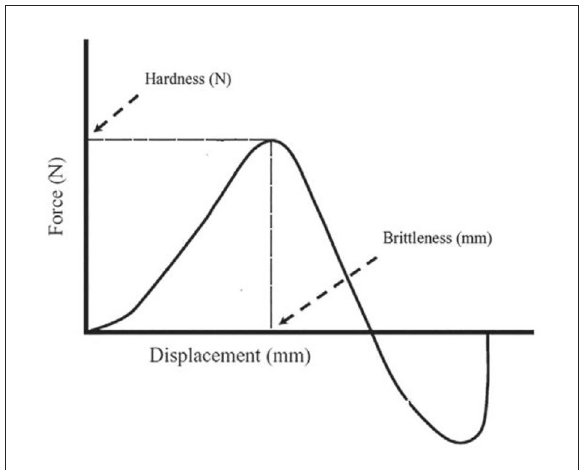
FIGURE1 Instrumental texture analysis yielded a force–displacement curve that displayed hardness and